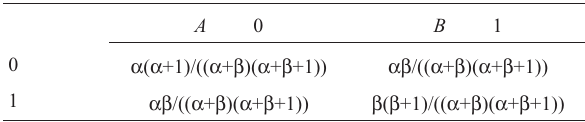
Table 3 - Integrated probabilities of independently-drawn gene pairs over the whole